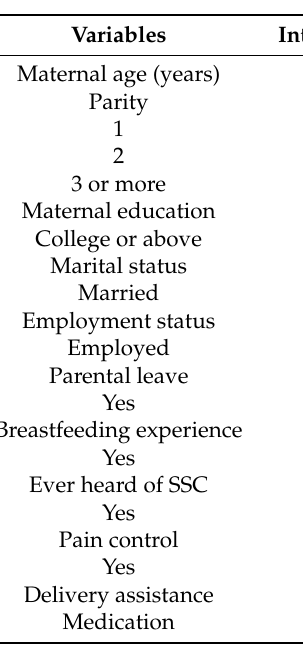
Table 1. Demographic characteristics of mothers.